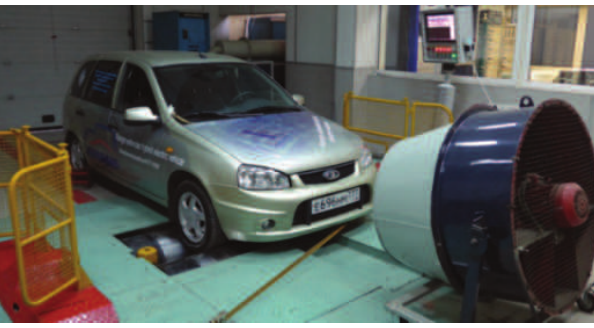
Fig. 7. Fragment of bench tests